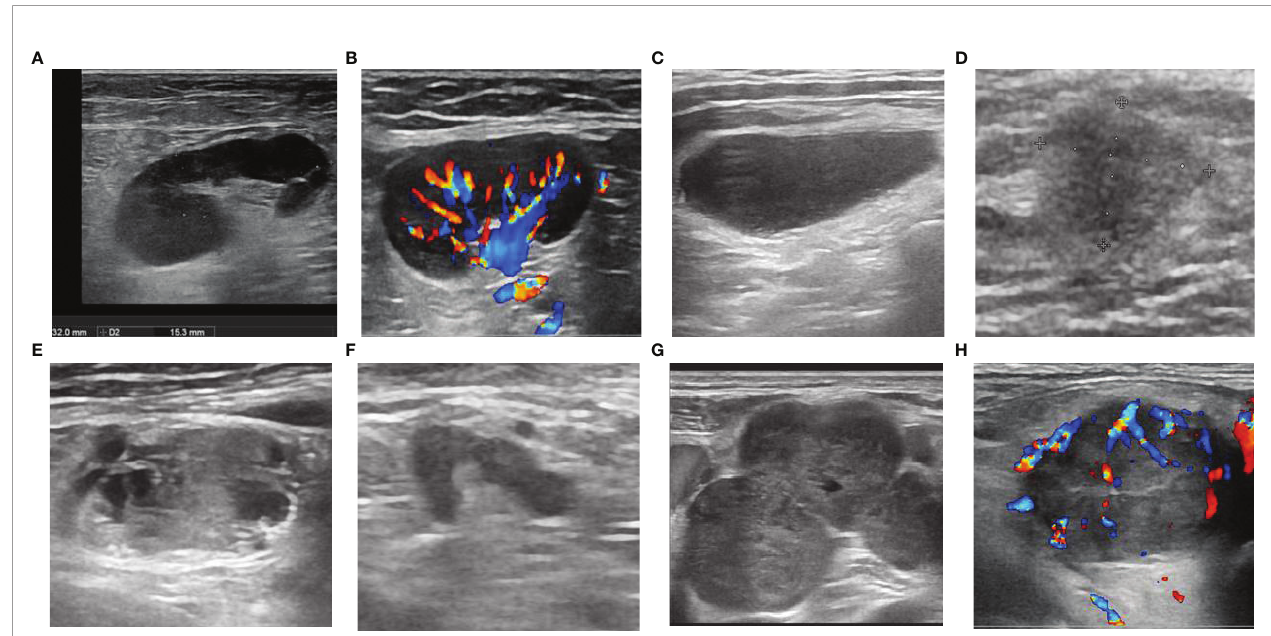
FIGURE 1 | Ultrasonographic features of lymph nodes (LNs). LNs with (A) sharp border, regular margin, hilum, homogeneous cortex, (B) hilar vascularity, (C) absence of hilum, (D) blurred border, (E) calci fi cation and inhomogeneous cortex (necrosis), (F) irregular margin, (G) fusion, (H) peripheral vascularity.